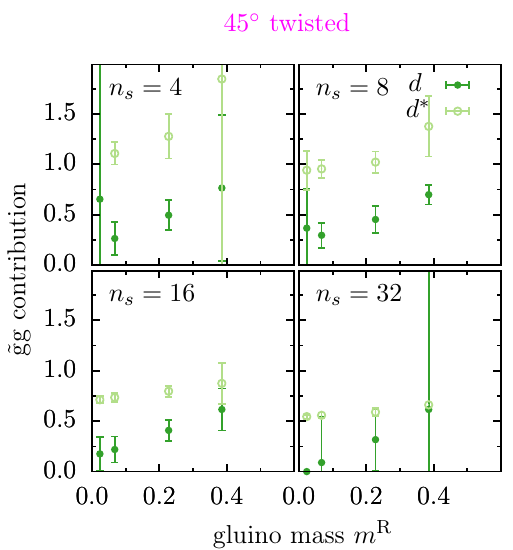
Figure 11 . Symmetric gluino-glue from a 16 3 × 32 lattice and for twist angle α = 45 ◦ versus the gluino mass m R . The different panels show data for n s = 4 , 8 , 16 and 32 stout smearing steps. For the fits, two time-slices have been excluded at both ends, t cut = (2 , 2) .